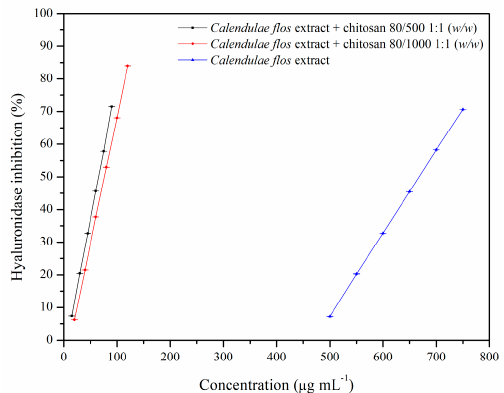
Figure 5. Anti-hyaluronidase activity of the Calendulae flos lyophilized extract and its chitosan delivery systems expressed as IC 50 (50% inhibition of enzyme activity).